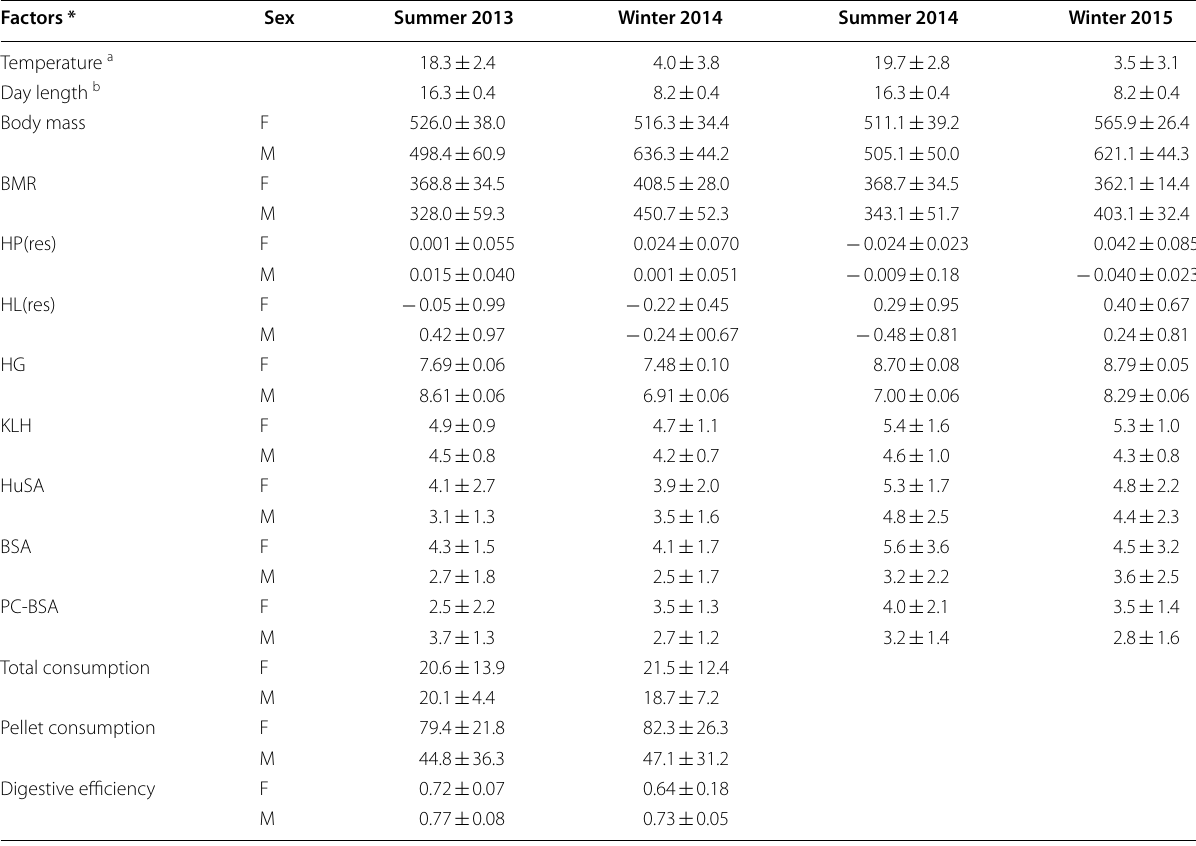
Table 1 Seasonal variation in day length, temperature, body mass, BMR, immune indices, diet and digestive